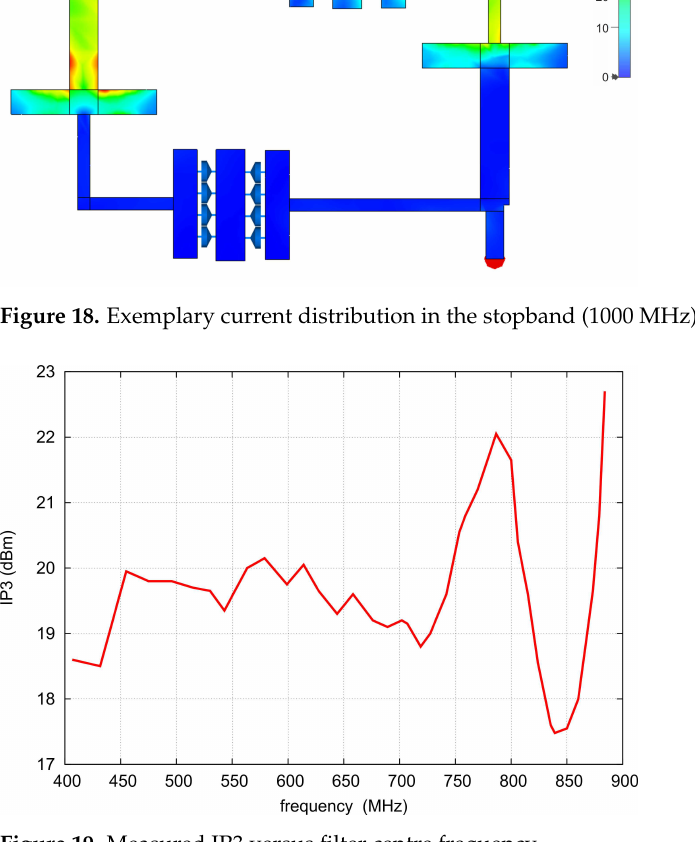
Figure 19. Measured IP3 versus filter centre